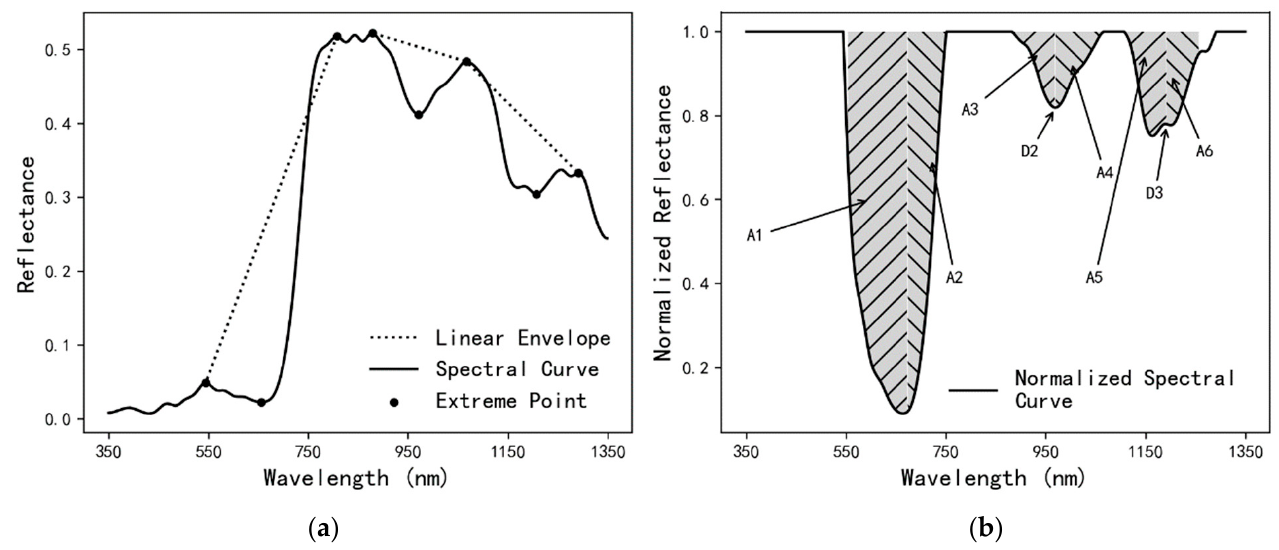
Figure 3. Illustration of deriving values of the absorption features parameters: ( a ) shows the process of retrieving upper envelope of the spectral curve; ( b ) shows the normalized spectral curve and the absorption features parameters.